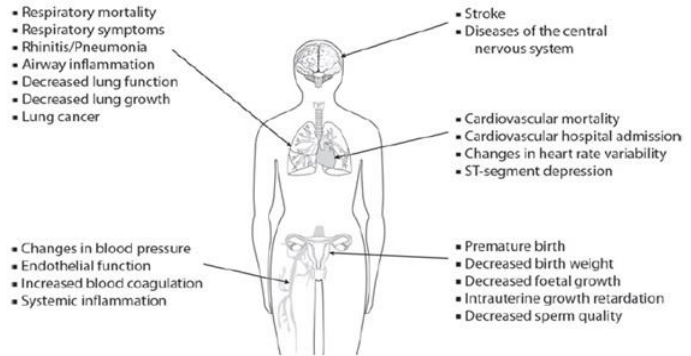
Figure 3. Diseases of the human body caused by PM (Adapted from Rückerl et al., 2011, with permission from Taylor & Francis, 2020).